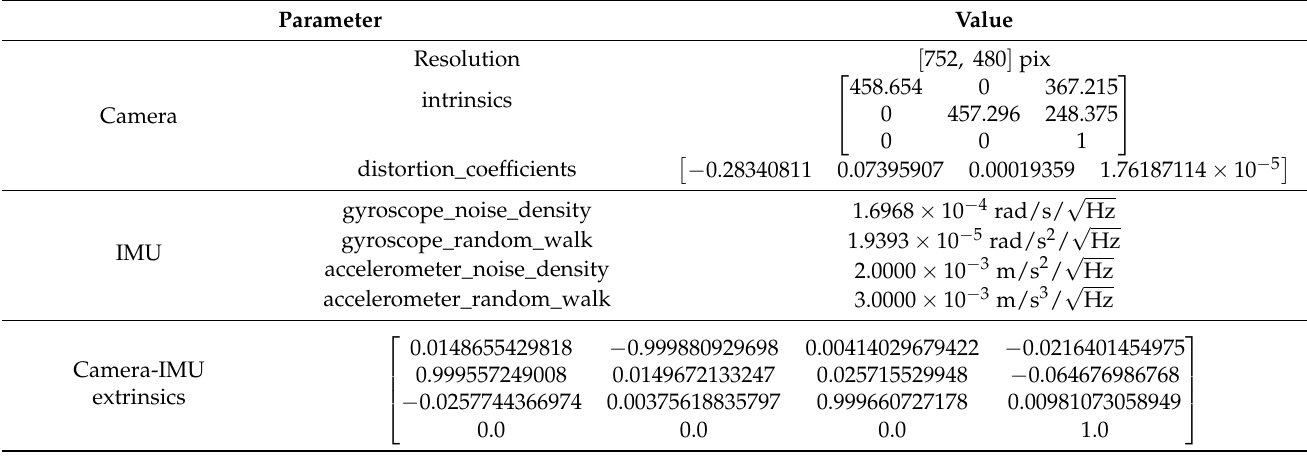
Table 6. Calibration values of internal and external parameters of the sensor (reprinted/adapted with permission from Ref. [42]).